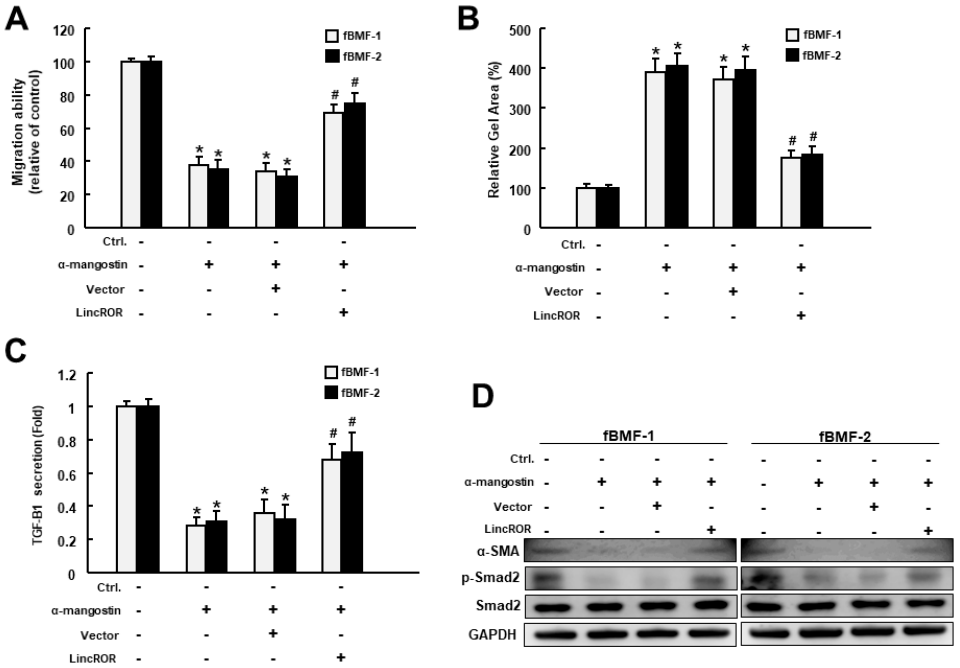
Figure 3 . α -mangostin suppresses the expression of fibrosis markers, components of TGF- β signal- ing, and LincROR in fBMFs. ( A ) α -mangostin dose-dependently downregulated the secretion of TGF- β 1 in fBMFs. ( B ) The protein expression levels of fibrosis (type I collagen) and myofibroblast markers ( α -SMA) were dose-dependently downregulated along with the reduced phosphorylation of Smad2 by western blot. ( C ) The lncRNAs expression level of LincROR in the α -mangostin-treated fBMFs were analyzed by a high-throughput RNA sequencing approach. ( D ) qPCR analysis was applied to analyze the relative LincROR expression level in α -mangostin treated fBMFs. ∗ p < 0.05 compared to the control.